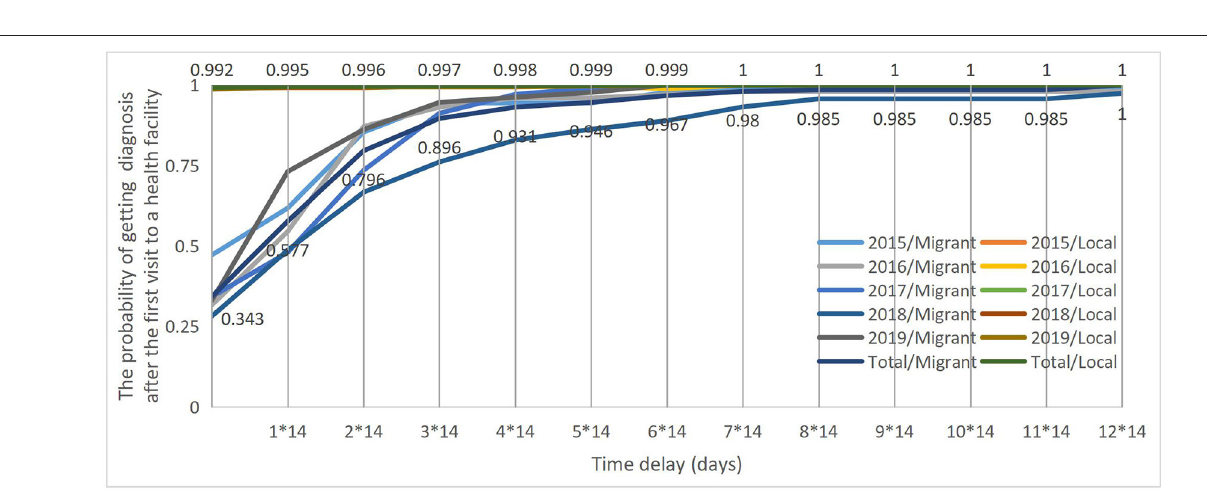
FIGURE 3 | Health system delay curves between migrant and local patients with TB from 2015 to